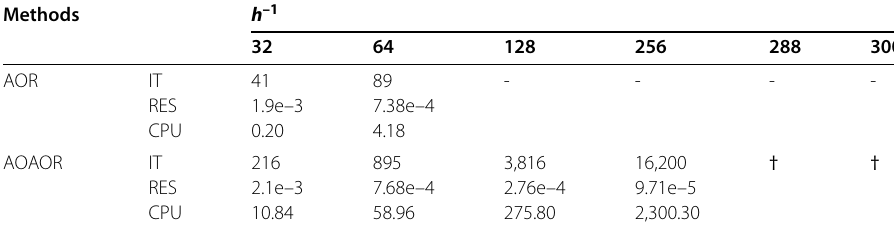
Table 2 Numerical results when ξ = ζ = σ = 0.0 ( ε = h 2 /5) Methods